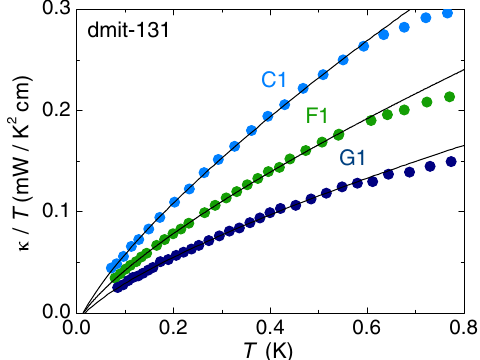
FIG. 2. Same data as in Fig. 1, for samples C1, F1, and G1. The black lines is a fit to κ =T ¼ a þ bT c below 0.5 K. The resulting fit parameters ð a; b; c Þ are listed in Table I for all samples. factor of 10 and 7.5 in Figs. 4(a) and 4(b), respectively. As readily seen, there is a massive quantitative discrepancy between the Kyoto data and the Sherbrooke data. At [Fig. 4(a)], compared to κ =T ¼ 0 . 05 mW = K 2 cm in our sample F1 — a factor 50. At T ¼ 0 . 7 K, κ =T ¼